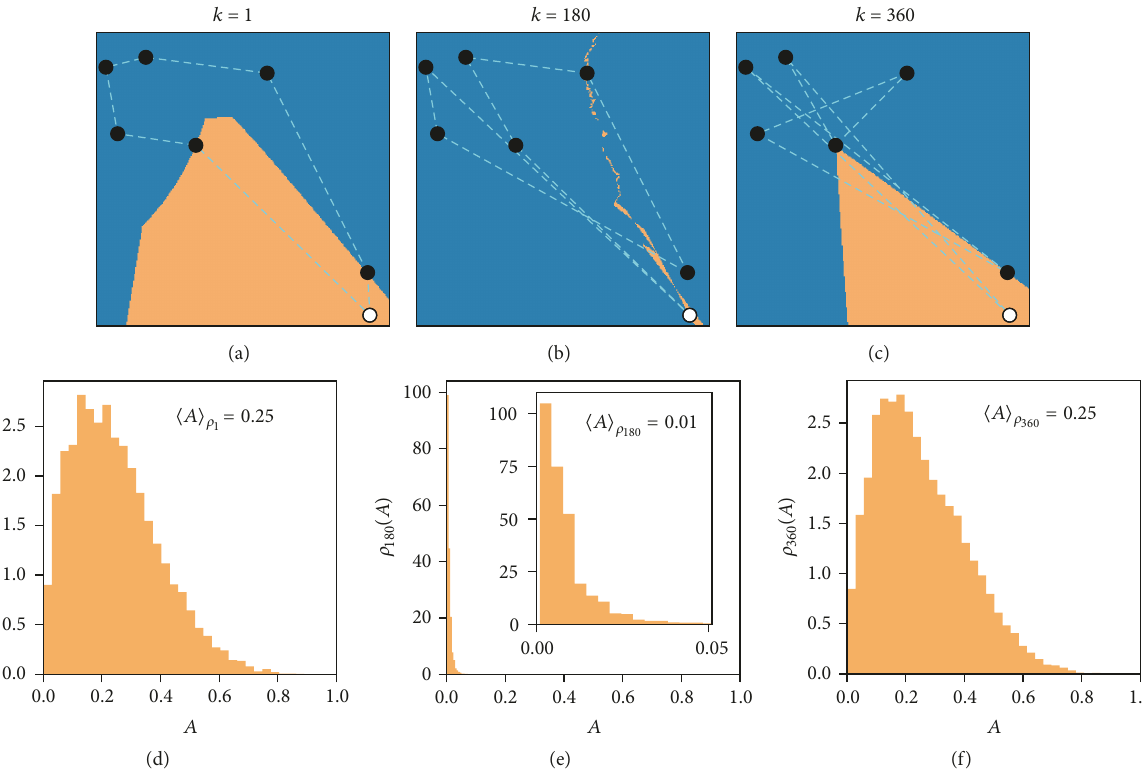
Figure 4: Stability of ranks under reallocation of sites . (a) Particular instance of the rTSP with 𝑁 = 7 and 𝑛 = 1 . Black points represent fixed sites, whereas the white one represents the site to be reallocated. The shortest trajectory is indicated as a dashed cyan line. When the white point is reallocated in the orange area 𝐴 , the shortest trajectory remains unchanged, while if a node is reallocated in any part of the blue area, the shortest trajectory changes. (b) Same realization of the rTSP, but for the trajectory with an intermediate rank ( 𝑘 = 180 ). The orange area is much smaller in this case. (c) Same realization of the rTSP, but for the longest trajectory ( 𝑘 = 360 ), where the orange area is again big. In panels (d), (e), and (f) we show the probability distributions of 𝐴 for 𝑁 = 7 and the three previous values of 𝑘 , as well as its mean value, ⟨𝐴⟩ 𝜌